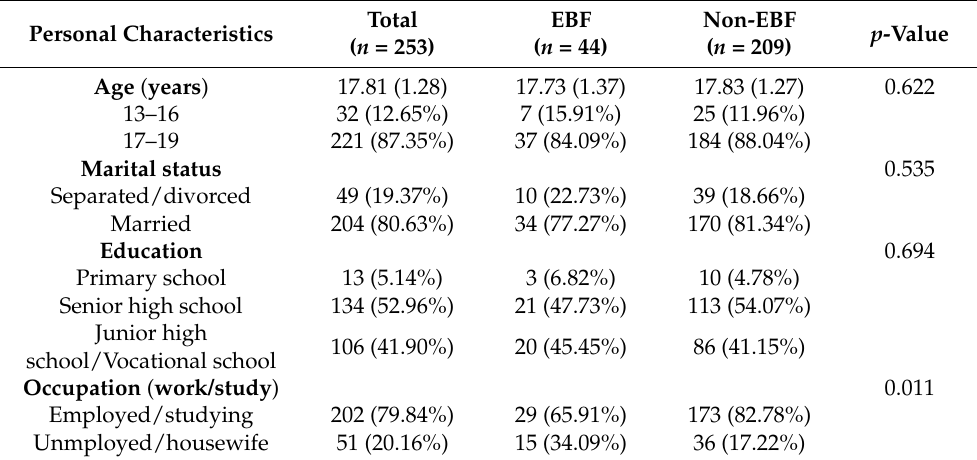
Table 2. Comparison of personal characteristics between exclusively breastfeeding mothers ( n = 44) and non-exclusively breastfeeding mothers ( n = 209).